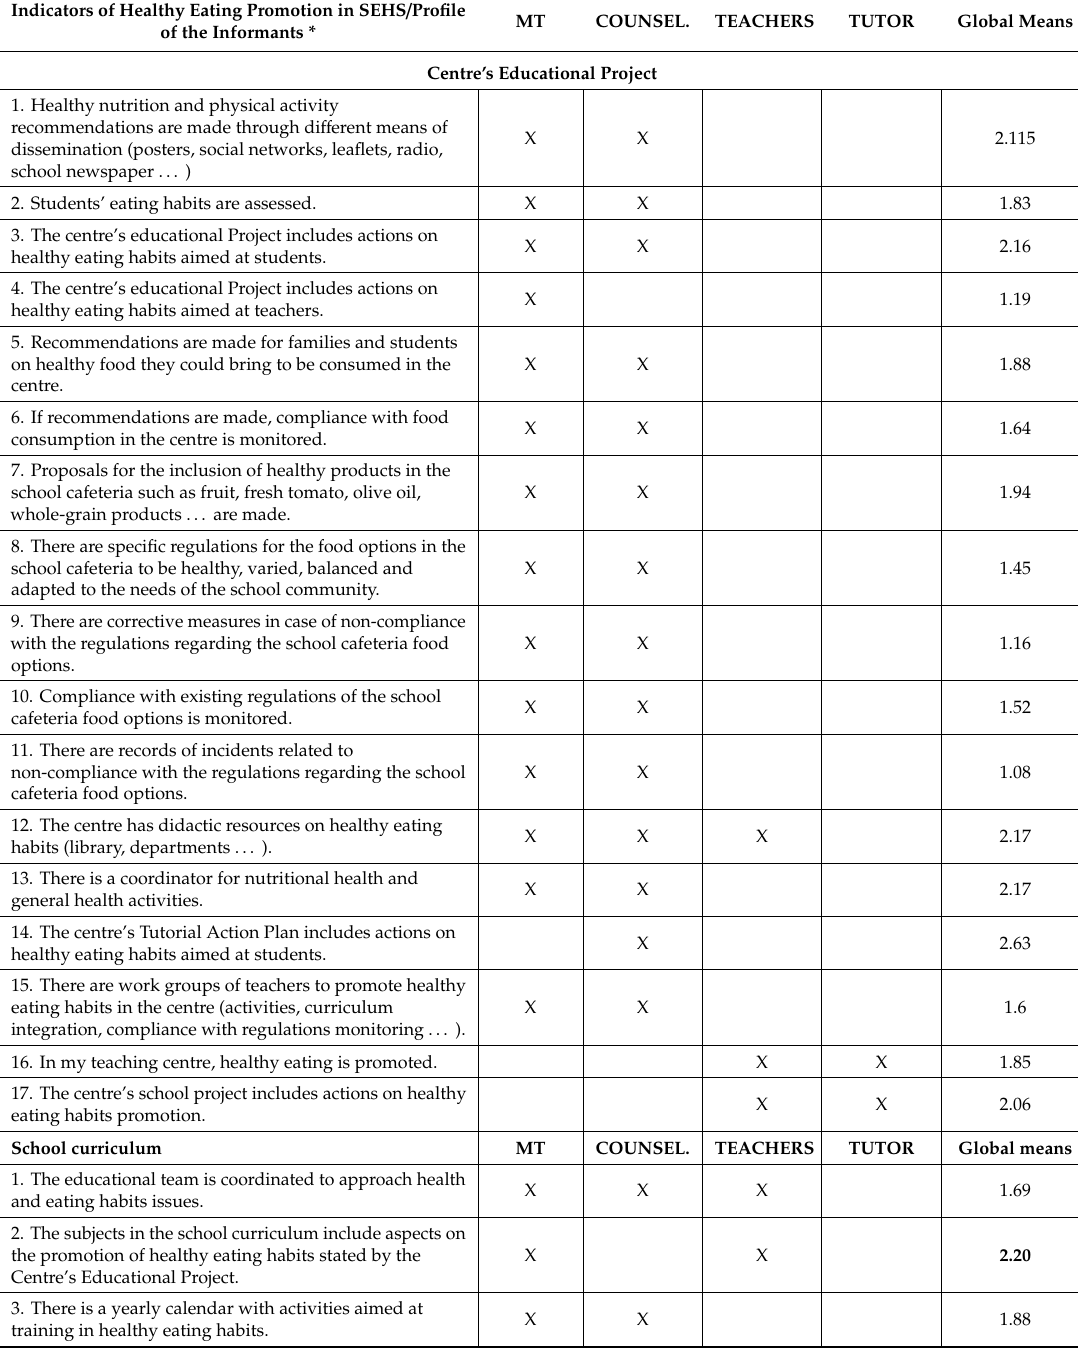
Table 5. Indicators of Healthy-Eating Promotion in SEHS. Profile of the informants of each indicator. Global means per